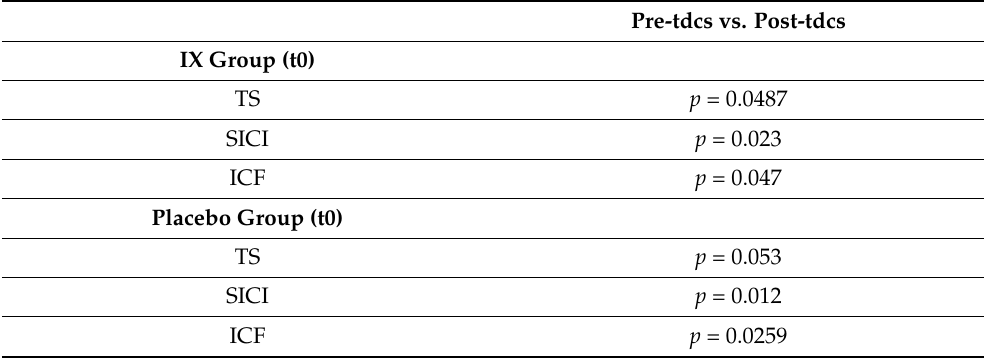
Figure 6. ( A ) MEP values for TEST stimulus, ( B ) normalized % MEP for SICI, and ( C ) normalized % MEP for ICF at T0 for placebo group are shown in pre vs. post-TDCS. Vertical bars denote 0.95 confidence intervals. (*) for p < 0.05. Table 1. Summary of pre-tDCS vs. post-tDCS in baseline conditions (T0) for IX and Placebo groups.